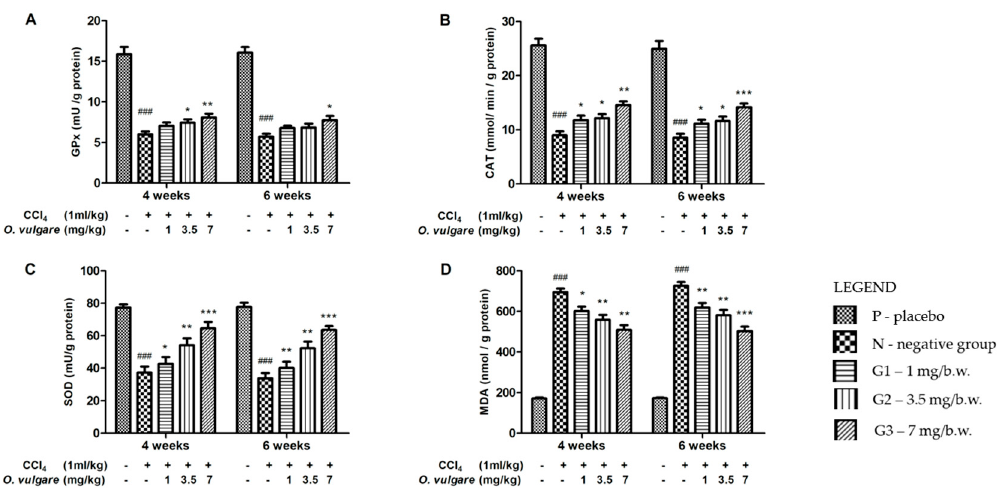
Figure 3. Effects of O. vulgare ssp. vulgare extract on: glutathione peroxidase (GPx) ( A ); catalase (CAT) ( B ); superoxide dismutase (SOD) ( C ); and malondialdehyde (MDA) ( D ) (mean ± SD, five animals/group). “+” is the group which received CCl 4 and “-” is the group which didn’t received CCl 4 . ### p < 0.001 compared to the reference group; * p < 0.05, ** p < 0.01, and *** p < 0.001 compared to the CCl 4 alone treated group.